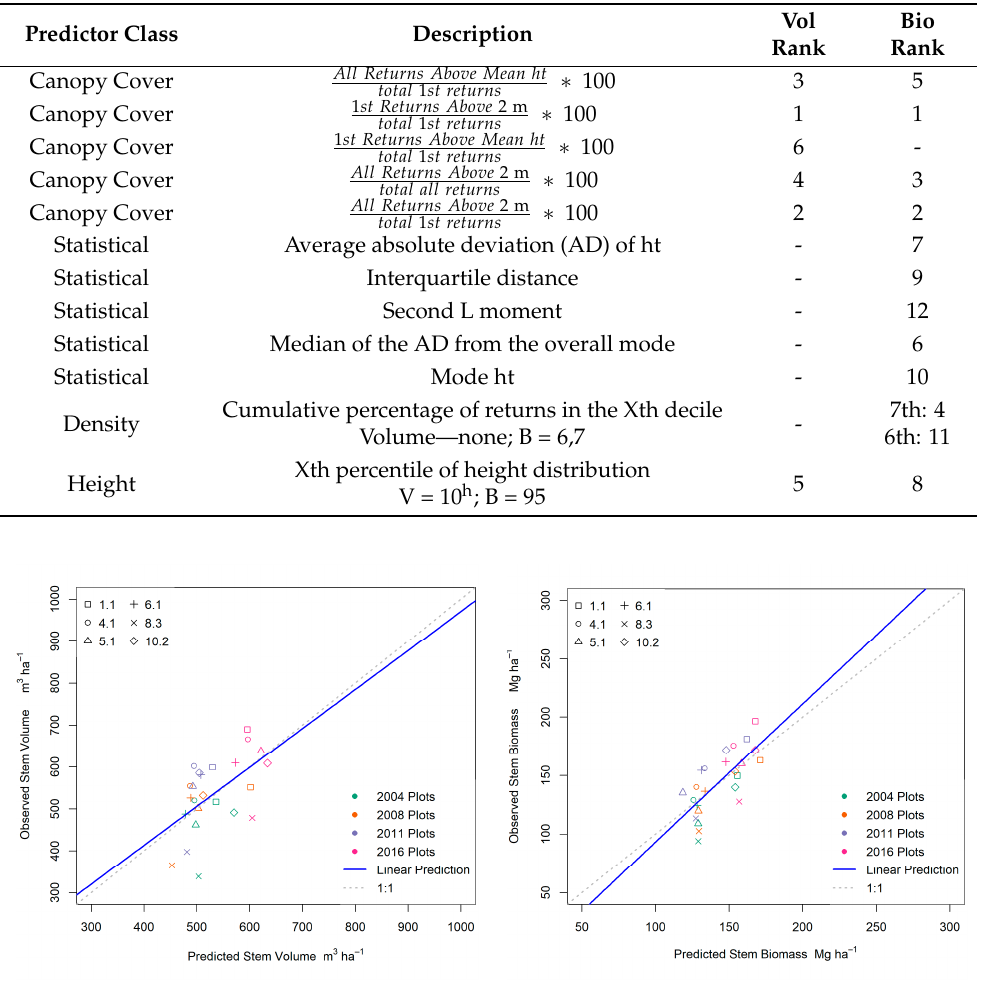
Table 4. LiDAR metrics selected and relative importance ranking for the volume (V, Vol) or biomass (B, Bio) models using Boruta variable selection method.